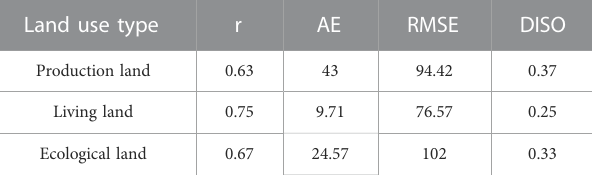
TABLE 3 Simulation accuracy of production land, living land, and ecological land from 2000 to 2020. Land use